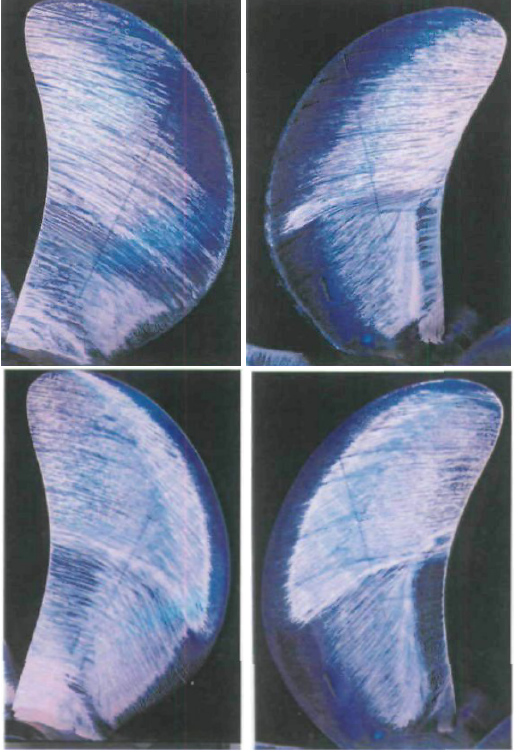
Figure 17. Propeller paint-tests with ( top ) and without leading-edge roughness ( bottom ) at Re = 5 × 10 5 for J = 0.568 [49]. Reproduced with permission from MARIN. k − ω SST Turbulence Model